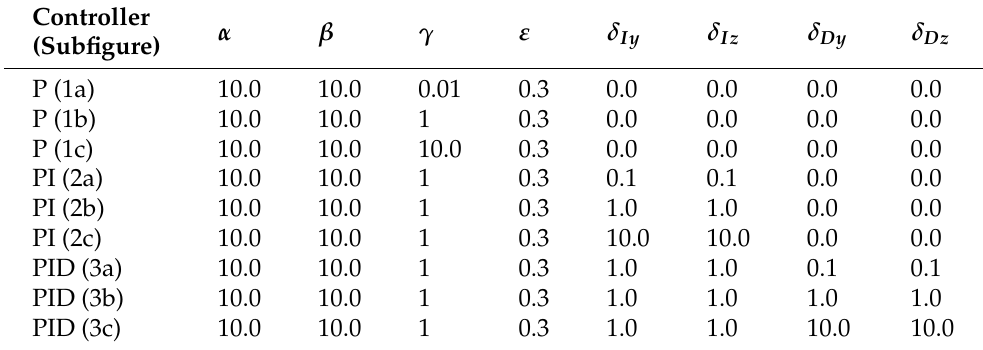
Table 2. Coefficient list for position tracking error plots from Figure